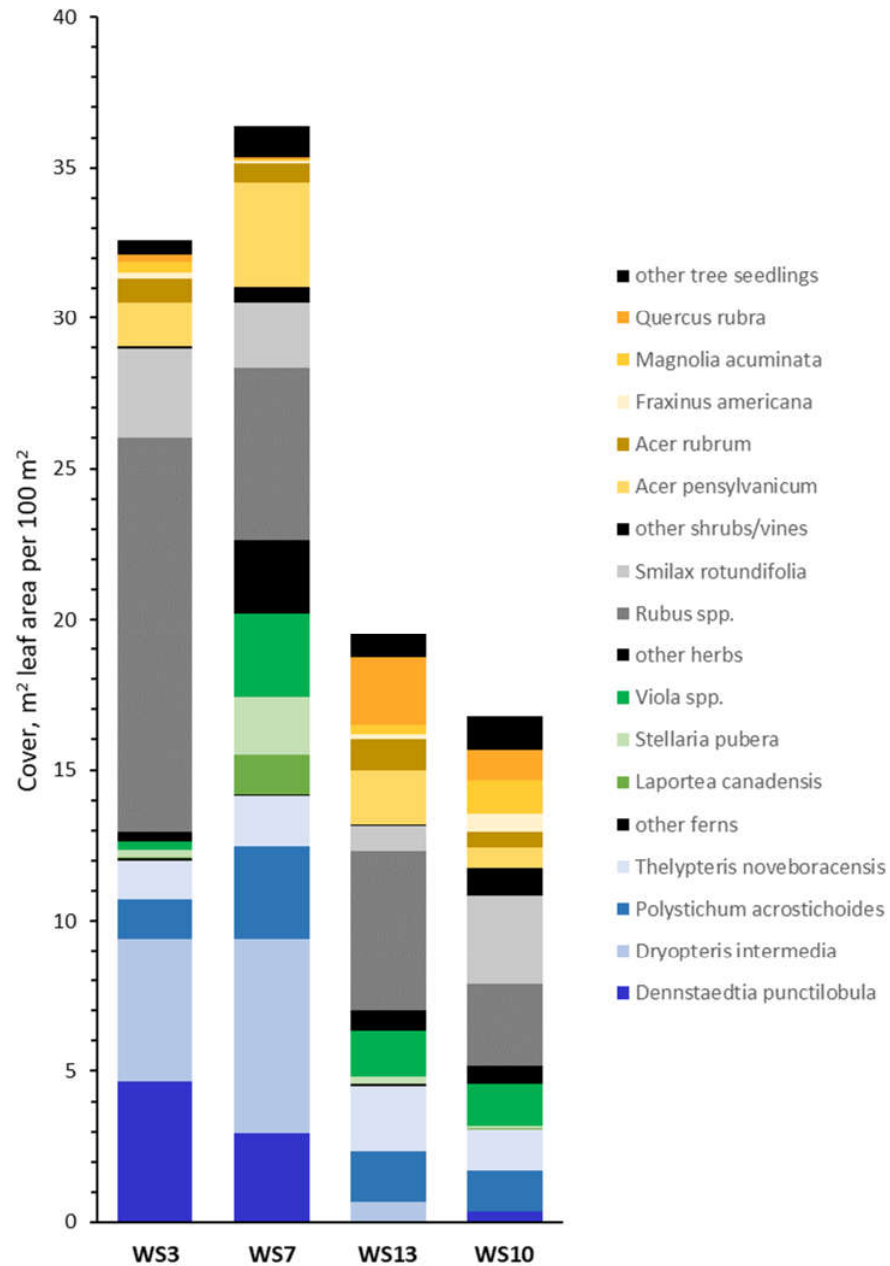
Figure 4. Watershed-level plant cover for the most important species in the summer of 2018. The 14 species shown contributed 97%, 89% 85%, and 93% to the total cover in WS3, WS7, WS10, and WS13, respectively. Note that watersheds (WS) are arranged on the x -axis so that those analyzed as a pair (Table 2) are adjacent to each other. Data are from the Fernow Experimental Forest, West Virginia, USA.